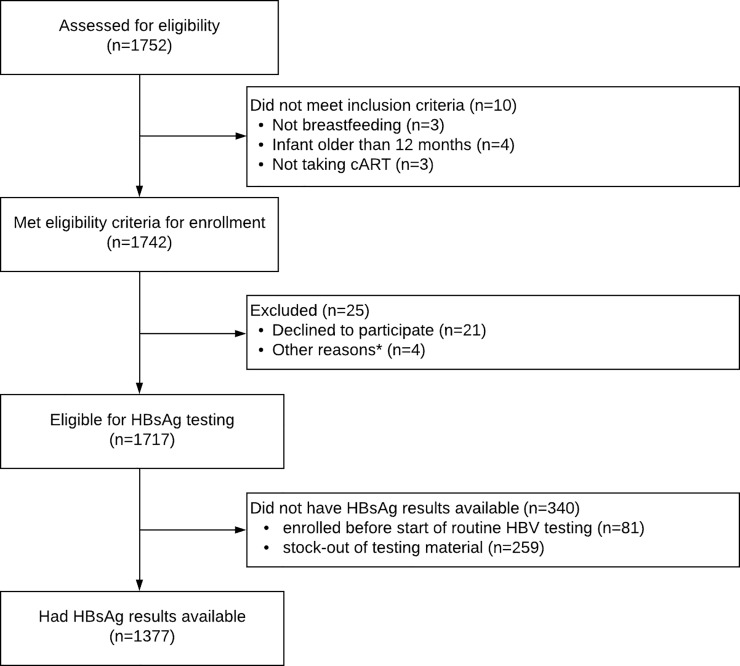
Participants’ flowchart.*Other reasons include hearing-impairment for one participant and intent to transfer to a different clinic for three participants.